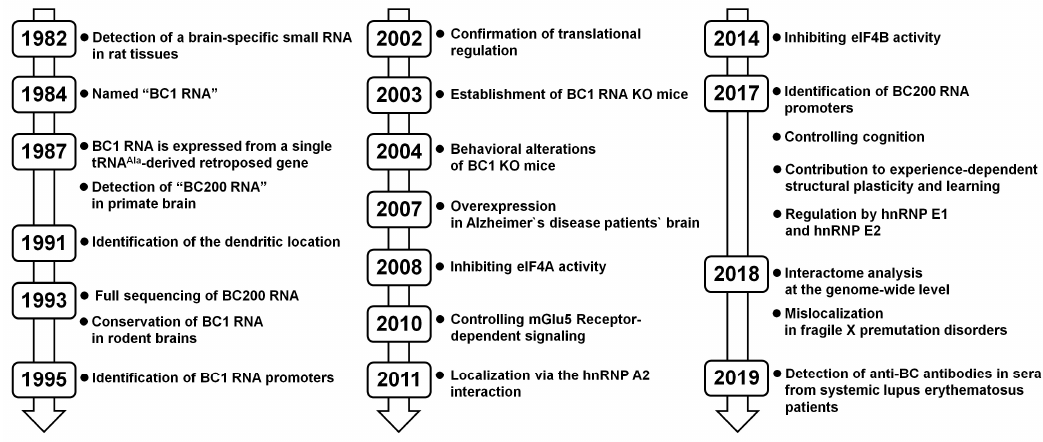
Figure 3. History of BC RNA studies in neurons.